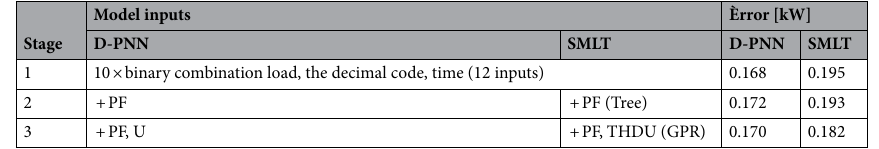
Table 2. Power P 3-step model estimations.